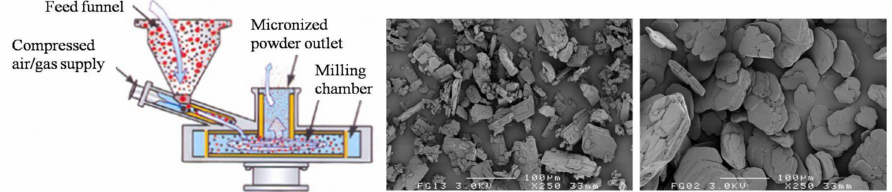
Figure 3. Preparation of dry powder by jet milling. Jet mill and its component ( left ); scanning electron microscope image of jet-milled dry powder ( right